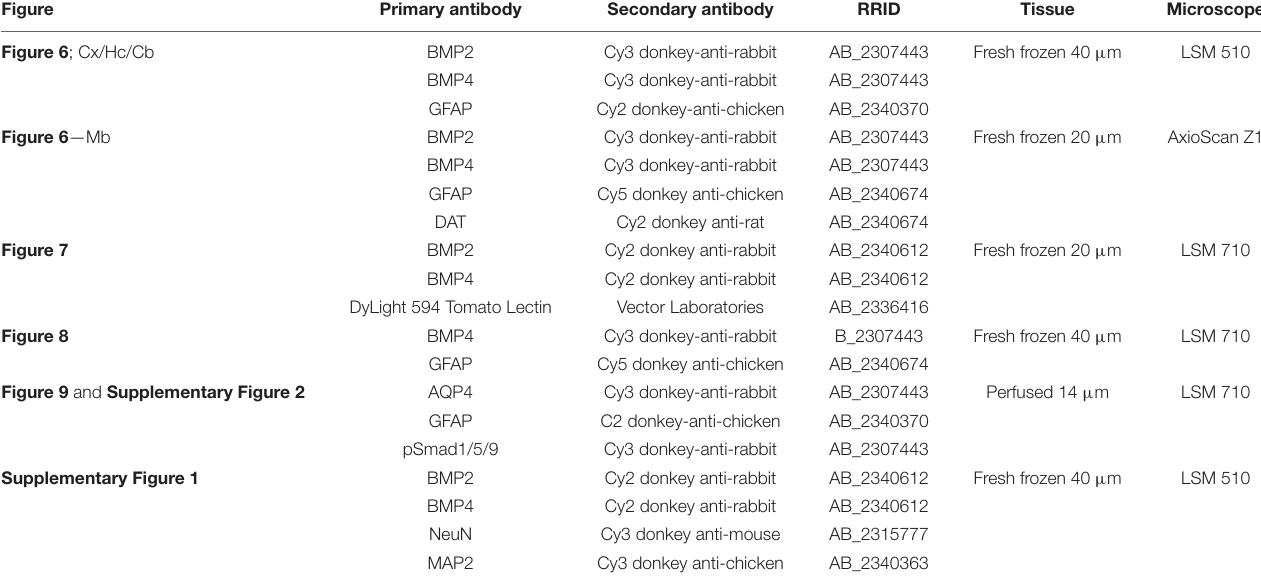
TABLE 3 | Secondary antibodies used for immunostaining. Figure Primary antibody Secondary antibody RRID Tissue Figure 6 ; Cx/Hc/Cb